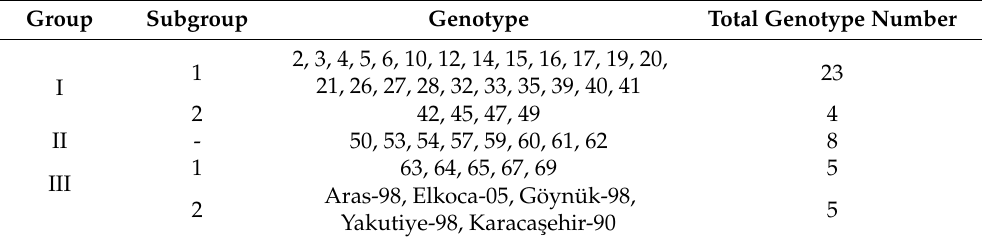
Figure 2. Dendrogram showing the genetic relationship between 45 bean genotypes generated by the neighbor-joining method of the MEGA software with the maximum composite likelihood substitution model using 27 SSR markers. Table 5. Groups and subgroups of P. vulgaris accessions determined as a result of Neighbor Joining (NJ) cluster